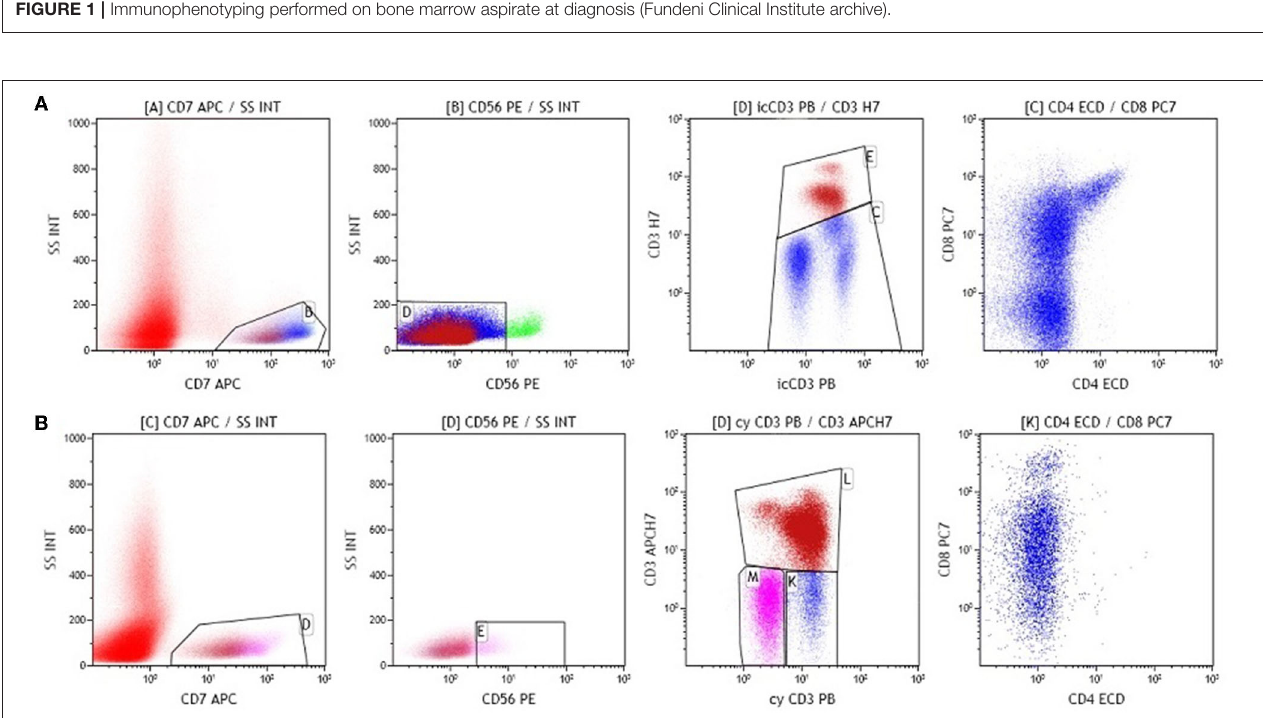
FIGURE 2 | Immunophenotyping performed on bone marrow (A,B)